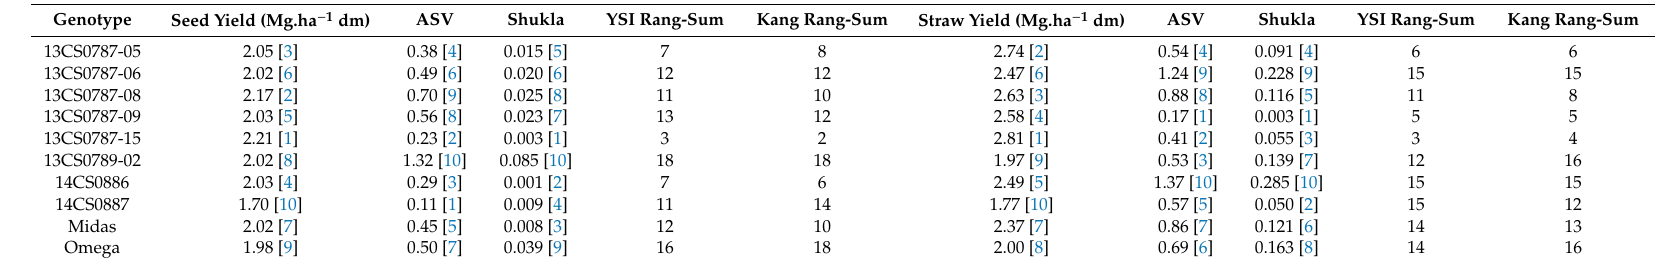
Table 4. The genotype means and stability indices for seed yield and straw yield. The number in square brackets denote rang value.